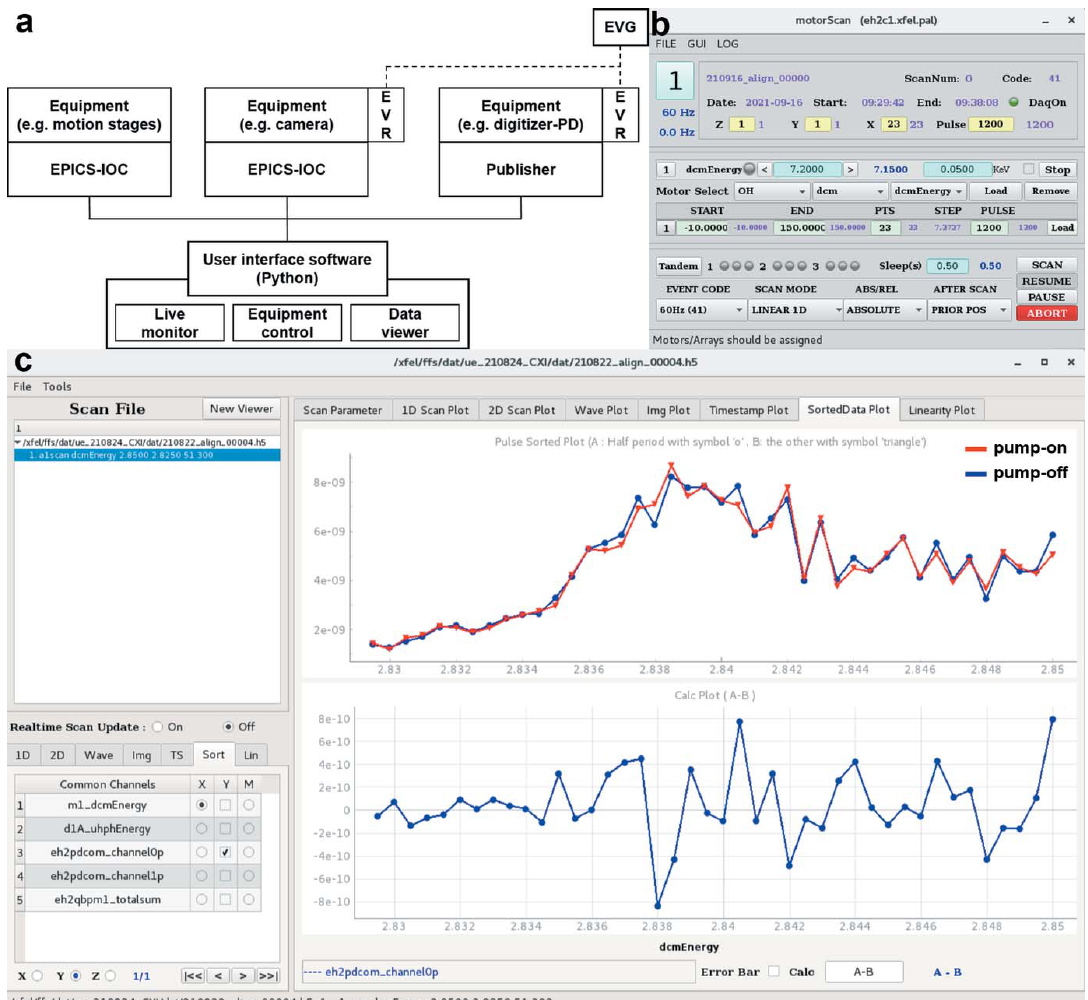
Figure 4 The DAQ and control software system at the PAL-XFEL. ( a ) A schematic diagram of the DAQ system at PAL-XFEL. Based on the event timing system, each X-ray pulse is named by a time-stamp and all operations are synchronized by trigger signals. Home-built control software transmit queues to operate single equipment or plural ones. ( b ) In-house developed main control panel. It executes queues for motion movement and data collection. ( c ) A panel of the data viewer. It displays collecting data in real time and provides a sorting function for pump–probe experiments. The upper graph shows pump-on and pump-off data together and the lower one displays the result of the arithmetic operation. Here, it shows the differences between two data